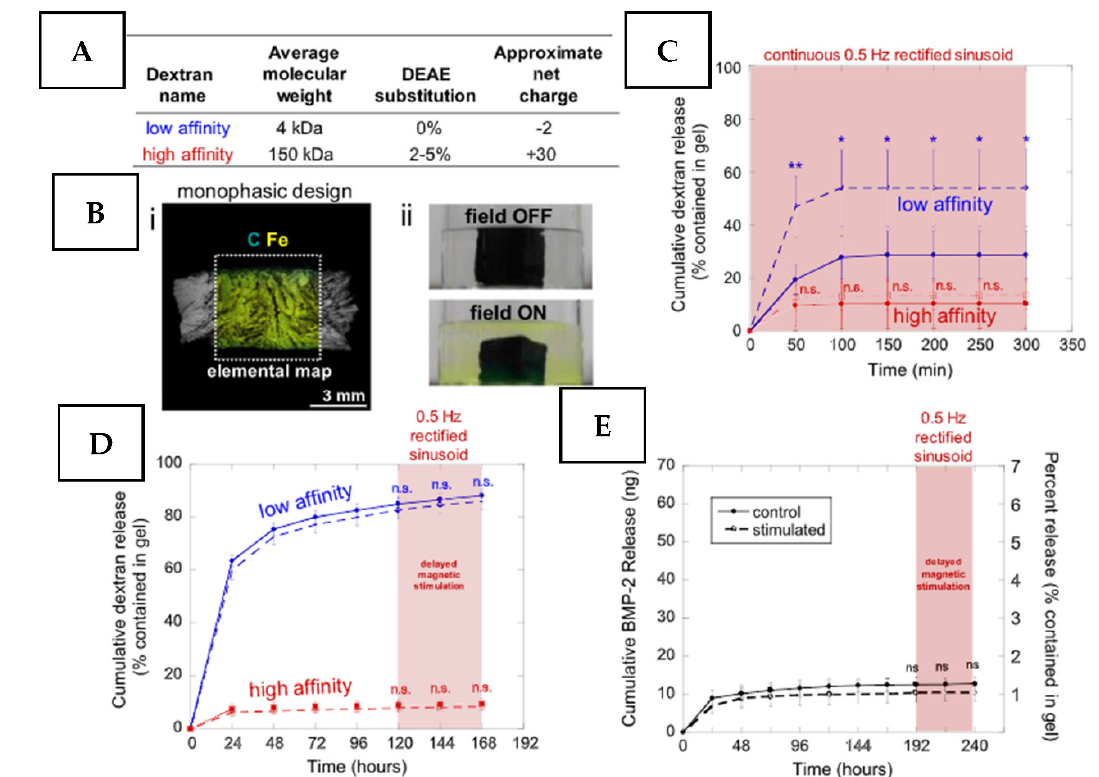
Figure 5. Demonstration of magnetic stimulation for enhanced release from monophasic ferrogels: ( A ) A table providing the theoretical size, diethylaminoethyl substitution, and estimated net charge for the dextrans labeled with fluorescein isothiocyanate (FITC) used in this study. ( B ) (i) Scanning electron microscopy image with elemental mapping of a dehydrated monophasic ferrogel. (ii) Photographs of a monophasic ferrogel loaded with 4 kDa FITC-dextran before (top) and during (bottom) magnetic compression. ( C ) Cumulative release vs. time for low (blue) and high (red) affinity dextrans when monophasic ferrogels were either not magnetically stimulated (solid) or continuously stimulated with a 0.5 Hz rectified magnetic gradient (dashed). ( D ) Cumulative release vs. time for low (blue) and high (red) affinity dextrans when monophasic ferrogels were either nonmagnetically stimulated (solid) or stimulated with a 0.5 Hz rectified magnetic gradient from 120 to 168 h (dashed). ( E ) Cumulative and percentual release of mouse bone morphogenetic protein-2 (left and right vertical axes, respectively) vs. time when monophasic ferrogels were either not stimulated (solid) or stimulated with a 0.5 Hz rectified magnetic gradient from 192 to 240 h (dashed). In parts C–E, statistics were applied to compare the stimulated release to unstimulated release (N¼4). Reprinted with permission from [108]. Copyright 2018 Elsevier.